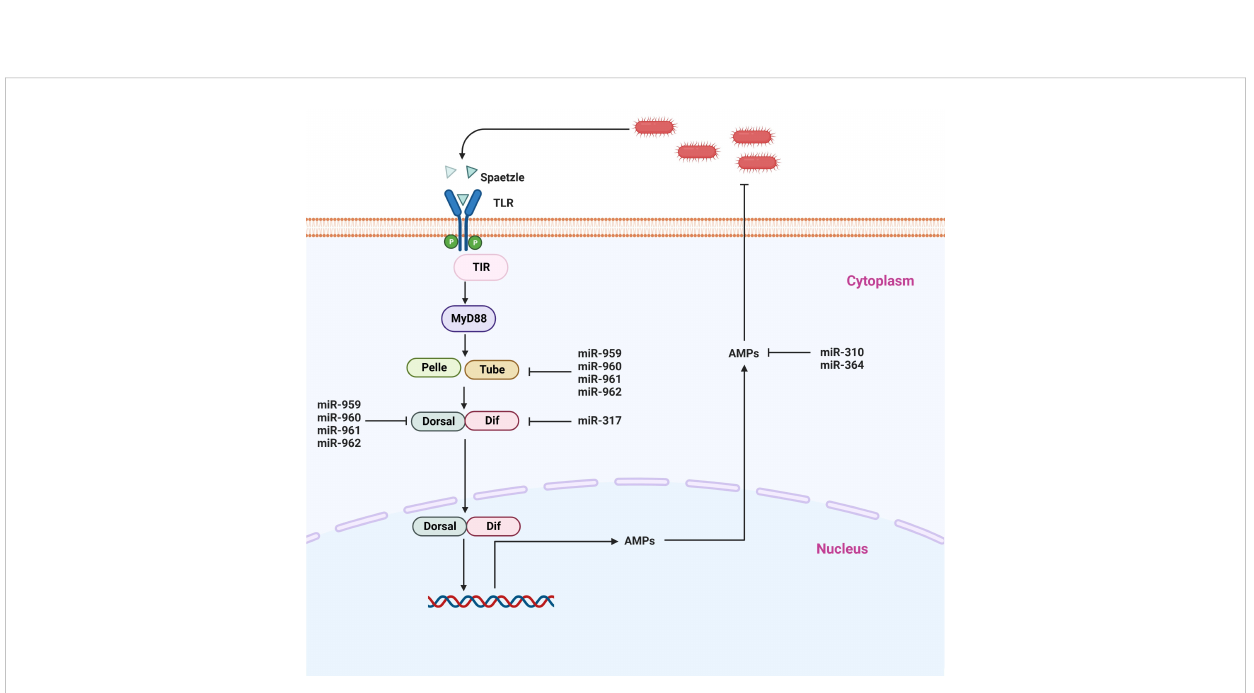
FIGURE 4 Representative microRNAs that control the Toll signaling pathway. Toll receptors recognize various bacterial components and either activate NF- k B signaling or induce other transcription factors via adapter molecules and downstream signaling